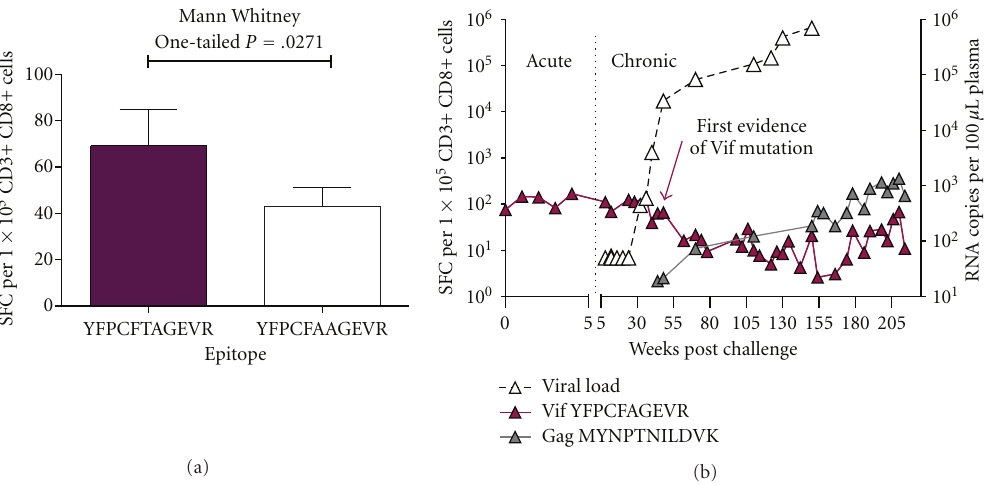
Figure 1: Viral Evolution in an Animal with no Known Protective Mamu Alleles. (a) Comparison of Vif-specific IFN- γ ELISPOT values for the vaccinated Mamu-A ∗ 01 − , - B ∗ 08 − , - B ∗ 17 − SP animal 16044 before and after an observed Vif YFPCFTAGEVR to YFPCFAAGEVR mutation. Statistical analysis was performed using the Mann Whitney test. (b) NASBA viral loads and ELISPOT results for acute (Vif) and chronic (Gag) epitopes were compared to determine the ability of CTLs targeting either the Gag or Vif epitope to control viral replication.